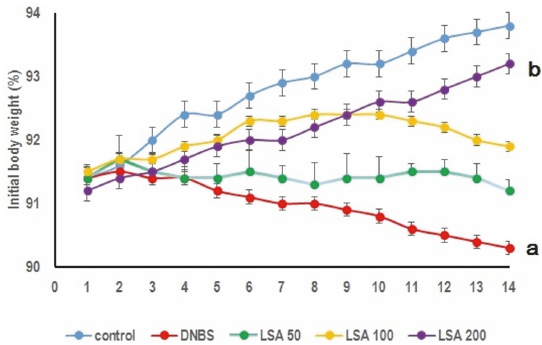
Figure 2: LSA instillation effects on mice with DNBS-induced colitis . Data were obtained from five independent experiments (n = 5), each of which contained five mice (total n = 25, error bar = SD). Body weight loss was observed in mice without LSA instillation (Group II) and Groups III–V were injected with different concentration of LSA. Mice of Group II (DNBS only) showed significant body weight loss compared to LSA-injected mice (a: p < 0.05), whereas Group V (LSA 200 𝜇 g/mL) injected mice weights were not significantly decreased compared to control. b: p < 0.001. Representative results obtained from five independent experiments are shown (ns: not